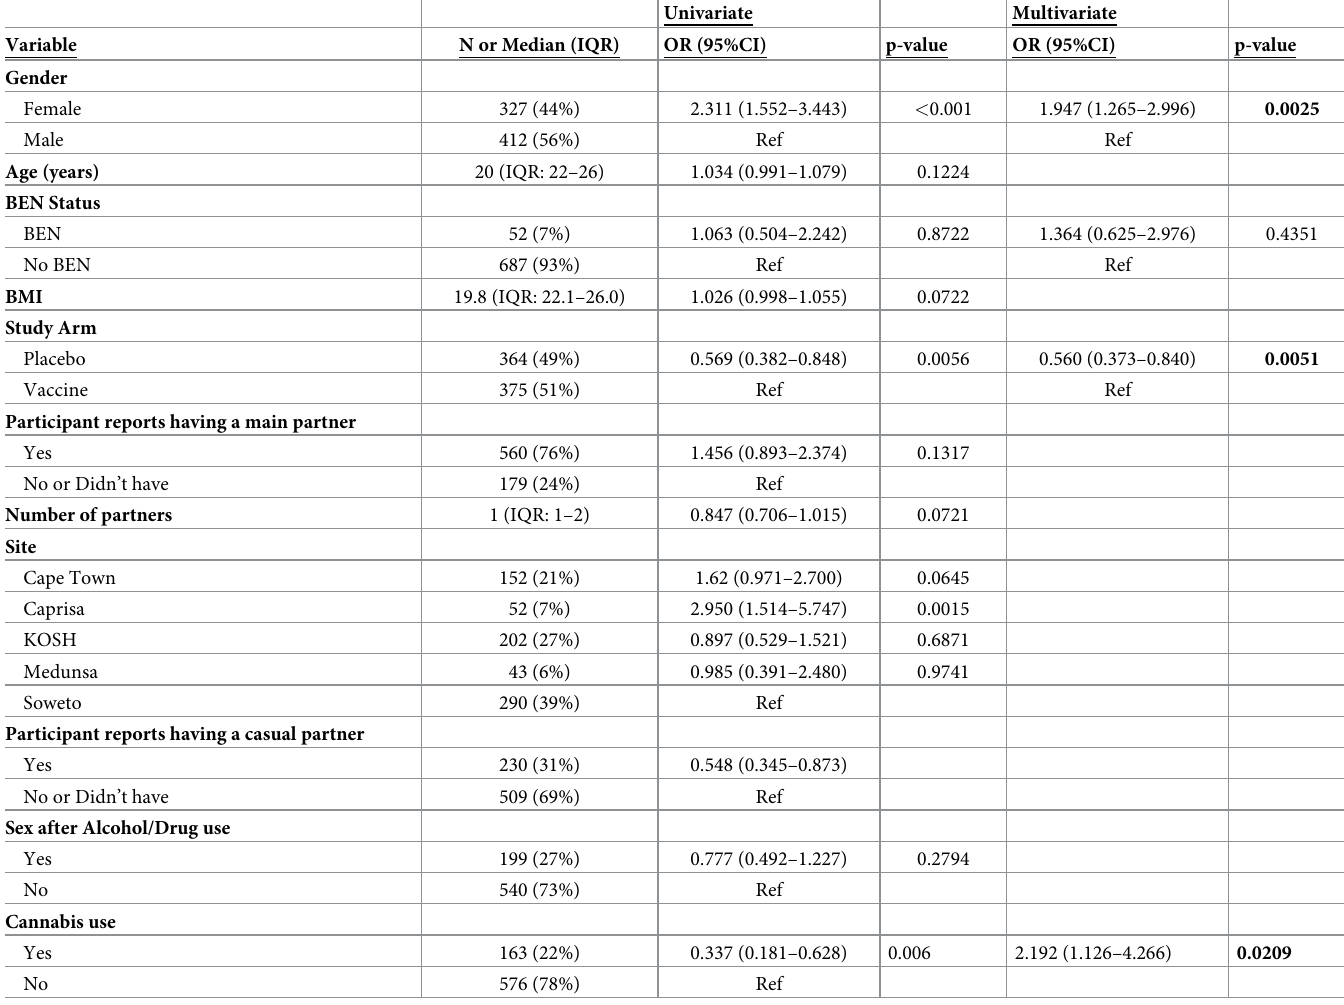
Table 3. Baseline predictors of HIV infection among HVTN 503 black